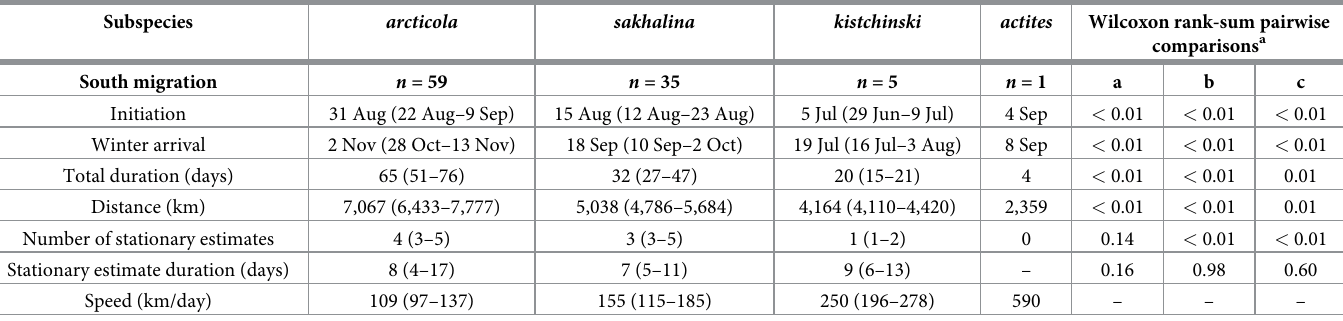
a “a” indicates a pair-wise comparison between arcticola and sakhalina ; “b”: arcticola and kistchinski ; “c”: sakhalina and kistchinski . No statistical comparisons were made with the actites subspecies due to a low sample size. P-values are